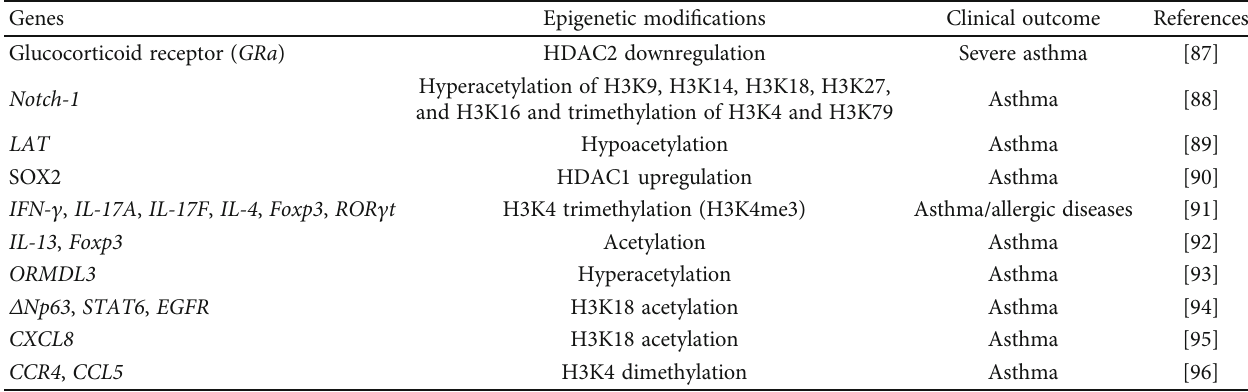
Table 2: Some histone-modi fi ed genes, epigenetic modi fi cations with clinical